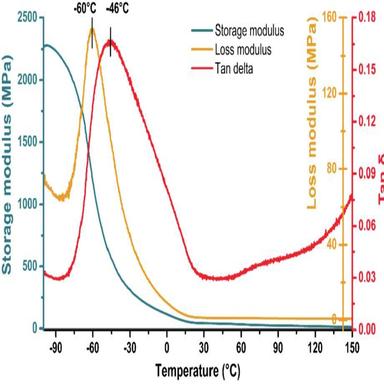
DMA curves of Bioflex® printout - storage, loss modulus and damping parameter.